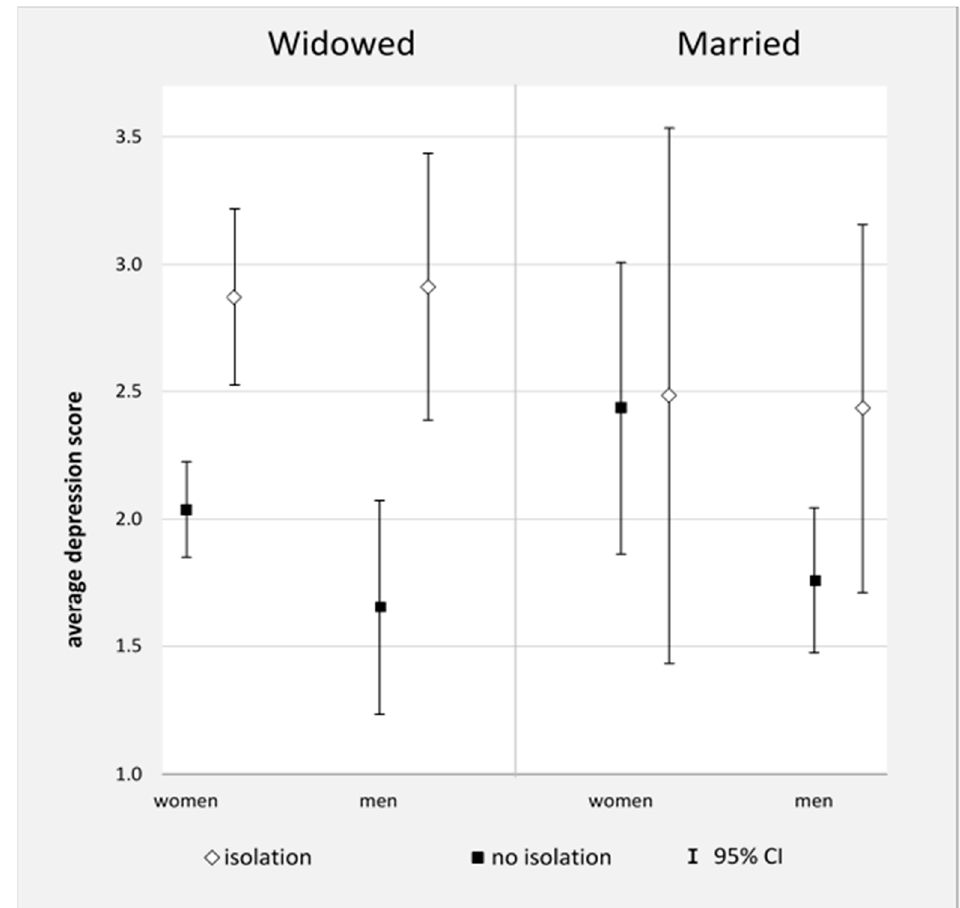
Figure 2. Average marginal effects of depression in the two subsamples “widowed oldest old” and “married oldest old” taking sex and social isolation into account. Notes: FU5 = follow-up 5, MMSE = mini-mental status examination.